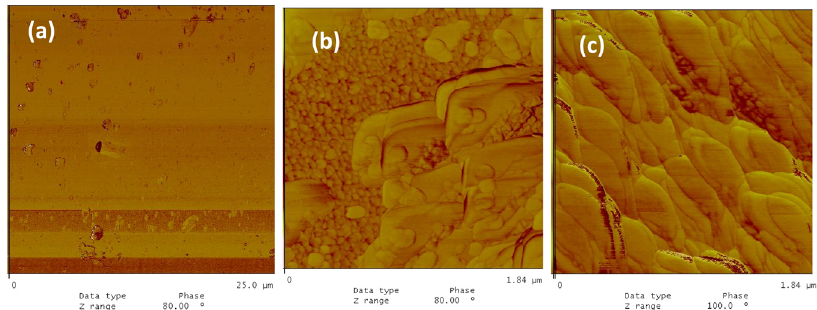
Fig. 8 The AFM phase images of adsorbed BSA on ( a ) glass, ( b ) glass/c-HAp fi lm ( c ) glass/ m-HAp fi